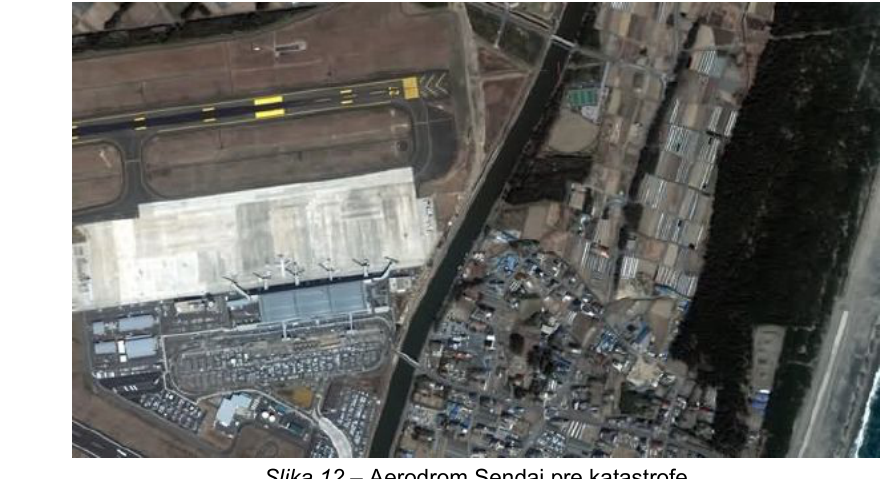
Figure 12 – The Sendai airport before the